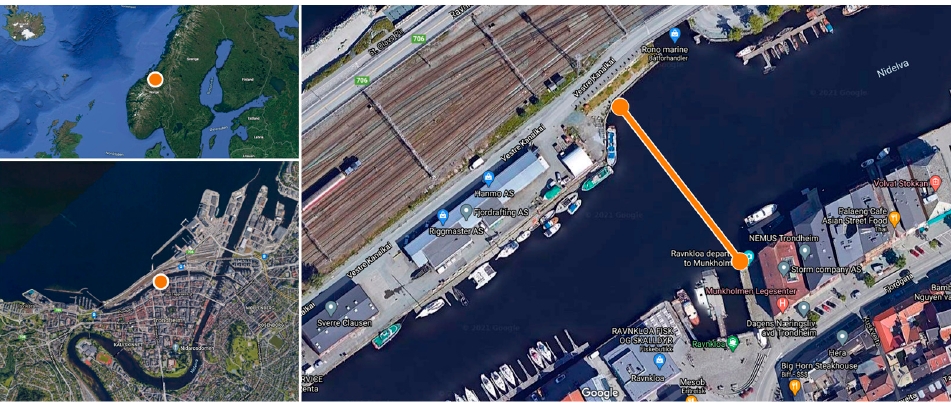
Figure 2. The milliAmpere2 will operate in Trondheim as a canal-crossing service over a 100-m-long urban canal.